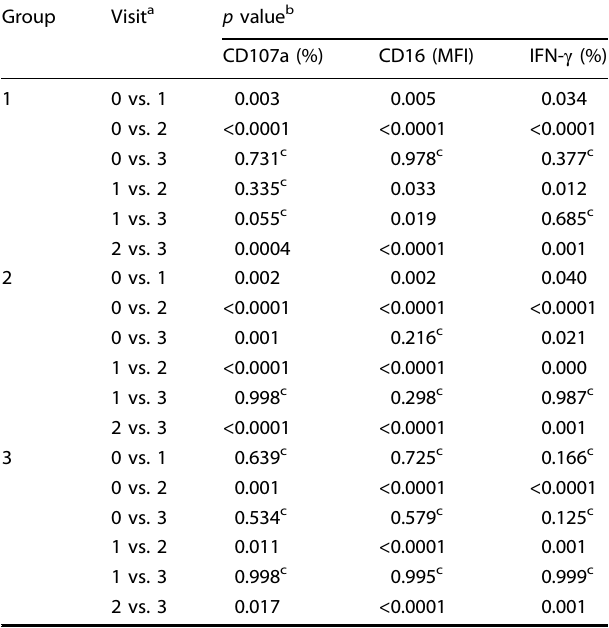
Table 2. Summary statistics for anti-EBOV GP-dependent NK cell